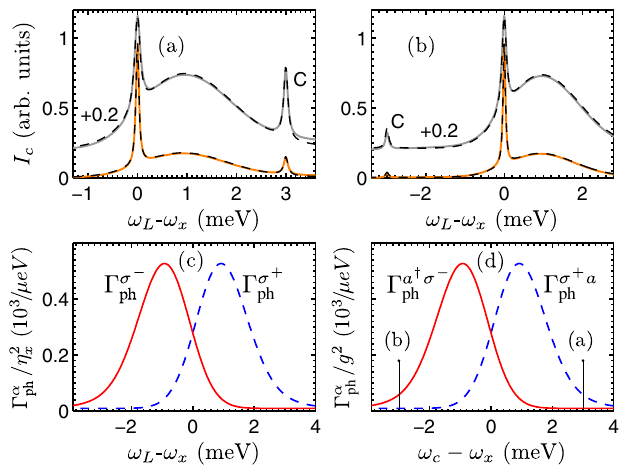
FIG. 5. Phonon bath at T ¼ 4 K . (a)-(b) Normalized cavity- ) for a dot-driven system as a function of mode intensity ( I c QD-laser detuning for two different dot-cavity detunings, ¼ 3 meV and (b) (cid:1) ¼ (cid:1) 3 meV , and for two different (a) (cid:1) cx cx values of the cw laser Rabi frequency (orange line, corresponds ¼ 20 (cid:8) eV , and grey, upper solid curve, corresponds to to (cid:4) x ¼ 40 (cid:8) eV ). Also shown (black dashed lines) is the PL (cid:4) x intensity obtained using the effective Lindblad form of the full time-convolutionless ME. Note that we have vertically shifted FIG. 6. As in Fig. 5 but with the phonon bath at T ¼ 20 K . The ¼ 40 (cid:8) eV by 0.2 for clarity. (c) Plot of the PL intensity for (cid:4) x system parameters are identical to those given in Fig. 3, except ¼ (cid:1) 3 meV as a (see text) for (cid:1) the phonon rates (cid:3) (cid:1) þ =(cid:1) (cid:1) cx ph that (cid:7) 0 ð 20K Þ¼ 20 (cid:8) eV and we now compute h B ið 20 K Þ ¼ 0 : 73 ð(cid:1) (cid:1) Þ ¼ (cid:3) (cid:1) þ ð (cid:1) Þ . function of QD-laser detuning. Note (cid:3) (cid:1) (cid:1) cx cx ph ph [cf. h B ið 4 K Þ ¼ 0 : 91 ]. For convenience, the scattering rates are (d) Plot of the phonon rates (cid:3) (cid:1) þ a=a y (cid:1) (cid:1) as a function of QD-cavity plotted in normalized units with respect to (cid:4) 2 ph regions marked by the black vertical lines indicate the cavity detuning. For convenience, the scattering rates are plotted in and g 2 . detunings used in (a) and normalized units with respect to (cid:4) 2 x